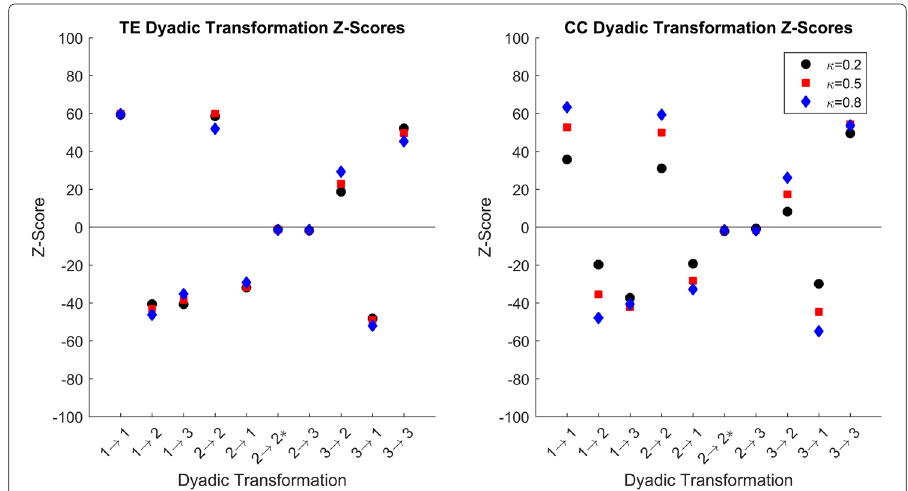
Fig. 7 Dyad Z -score over all κ . Average dyadic Z -scores for κ ∈ { 0.2,0.5,0.8 } for CC and TE. We see that CC Z scores have more variance over thresholds than do TE. We note that CC thresholds are closer to zero at low κ than TE. As κ increases, CC Z -scores come closer to TE Z -score values. For all thresholds, 2 → 2 ∗ and 2 → 3 are close to zero and the markers